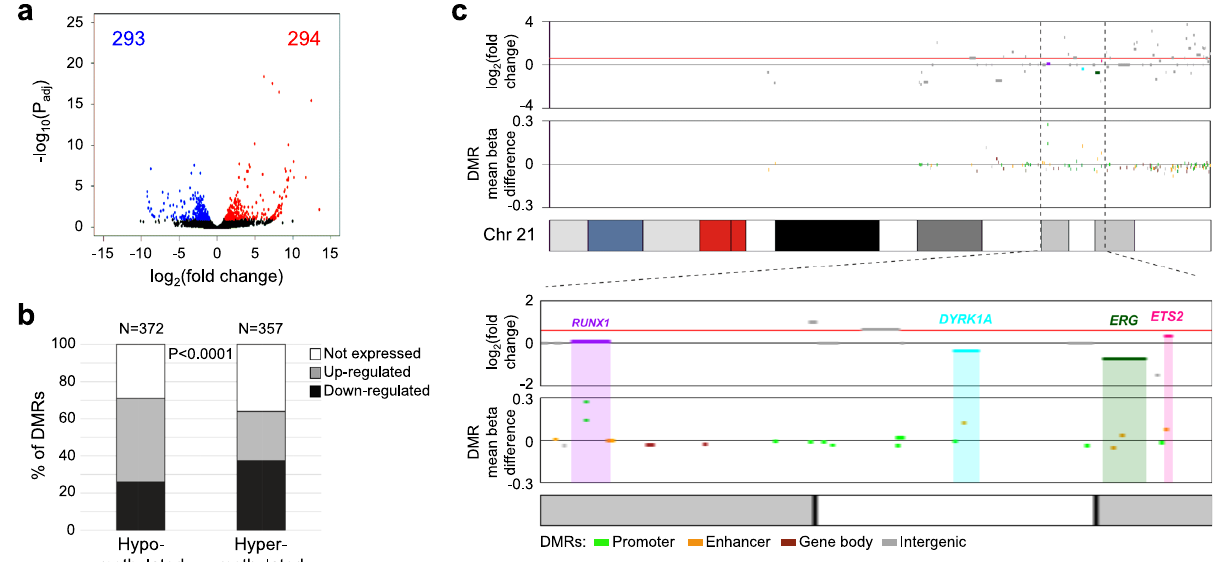
Fig. 6 Correlation between differential methylation in newborn dried bloodspots and differential gene expression in fetal liver CD34 + cells in Down syndrome (DS) and non-DS samples. a Volcano plot showing differential gene expression between DS ( N = 3) and non-DS ( N = 3) FL CD34 + cells, with signi fi cantly upregulated and downregulated genes (FDR-adjusted P < 0.1) highlighted in red ( N = 294) and blue ( N = 293), respectively. b Bar chart showing the number of hypomethylated ( N = 372) and hypermethylated ( N = 357) DS-associated differentially methylated regions (DMRs) that overlapped gene promoters/enhancers, and the direction of differential expression of the corresponding genes in DS versus non-DS FL CD34 + cells. For hypomethylated DMRs, 96 genes were downregulated and 167 genes upregulated (109 genes not expressed), whereas for hypermethylated DMRs, 134 genes were downregulated and 94 genes upregulated (129 not expressed), a difference that was highly signi fi cant in a two-sided Fisher ’ s exact test ( P = 9.20 × 10 − 7 ). c DS-associated DMR methylation levels and corresponding differential gene expression levels across chromosome 21. The zoomed-in plot below highlights four genes that play an important role in hematopoiesis, RUNX1 , DYRK1A , ERG , and ETS2 , all of which were overlapped by hypermethylated DMRs in promoters/enhancers and also demonstrated less than the expected 1.5-fold change in expression (indicated by the red horizontal line) in DS compared to normal FL CD34 +